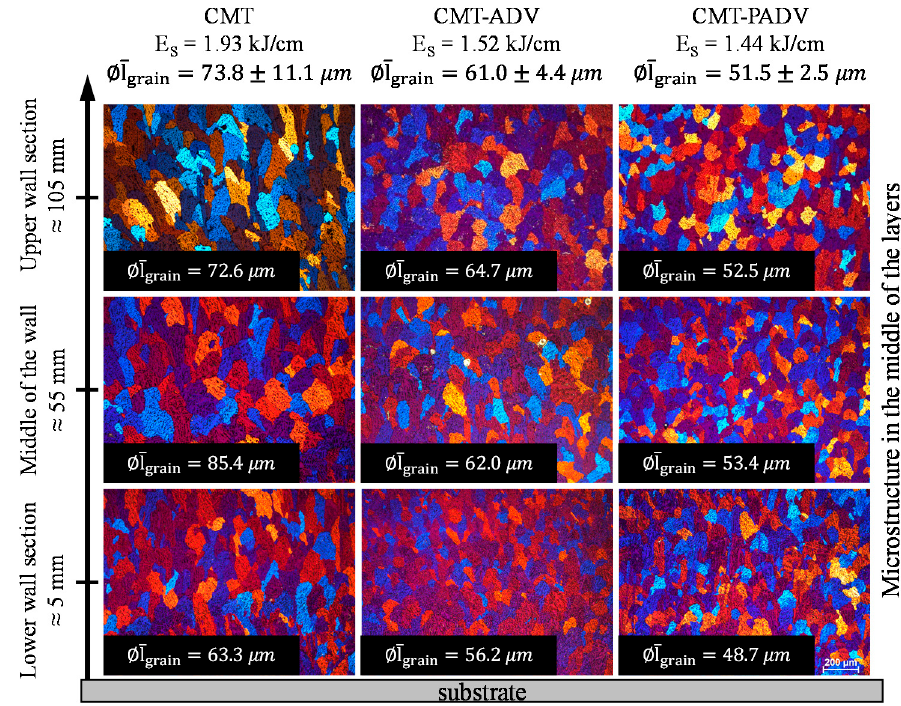
Figure 15. Comparison of the grain size in the center of the layer depending on the vertical distance to the substrate when using the CMT, CMT-ADV and CMT-PADV mode and the indication of the average linear grain size in the respective range.